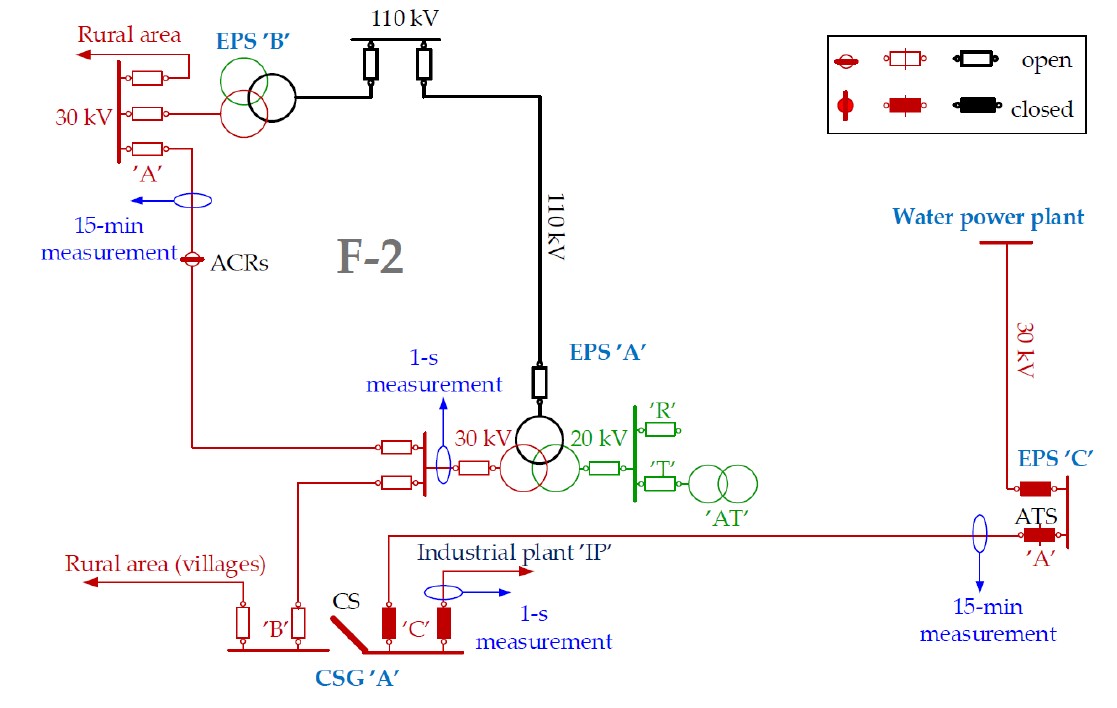
Figure 3. The system structure in the outage condition F-2 in the fail state of a 110 kV and 30 kV line. The considered distribution network area in the outage condition F-2 with the ESS implemented into EPS “A” (Figure 5) and after appropriate reconfiguration of the 30 kV network can work as an island operation condition F-2* (Figure 4).